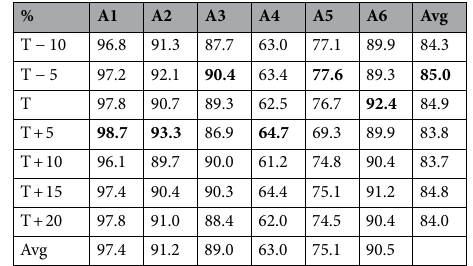
Table 5. Classification results for the mask data domain, with patent features and different threshold values.